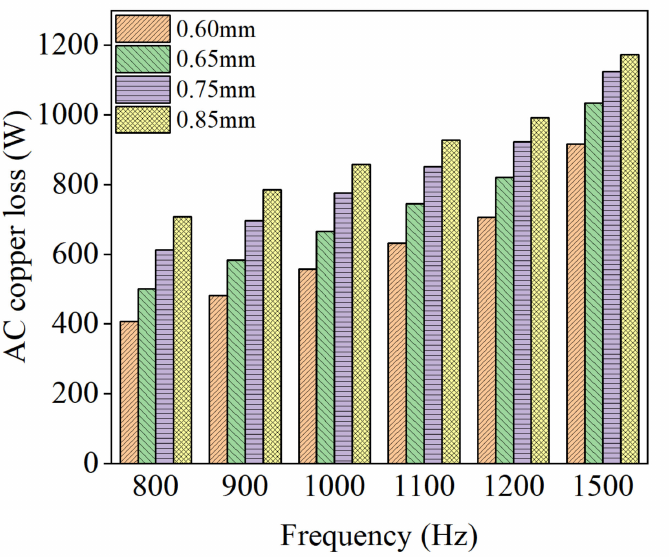
Figure 8. AC copper loss with conductor diameter under different frequencies for Case